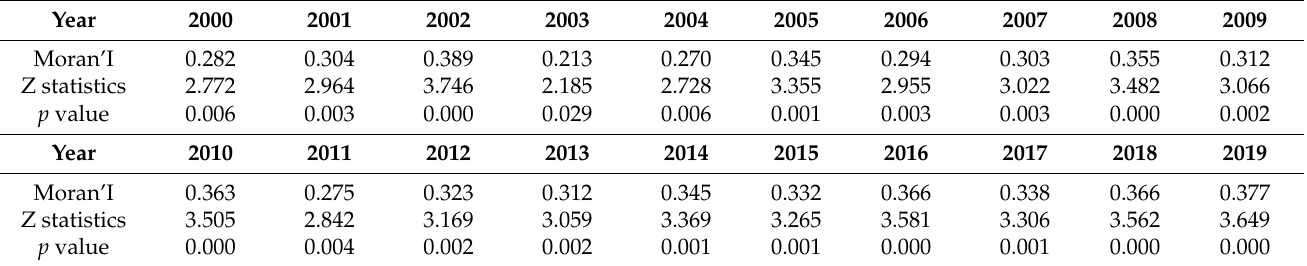
Table 3. Global Moran’s I index and Z statistics of China’s EIICI from 2000 to